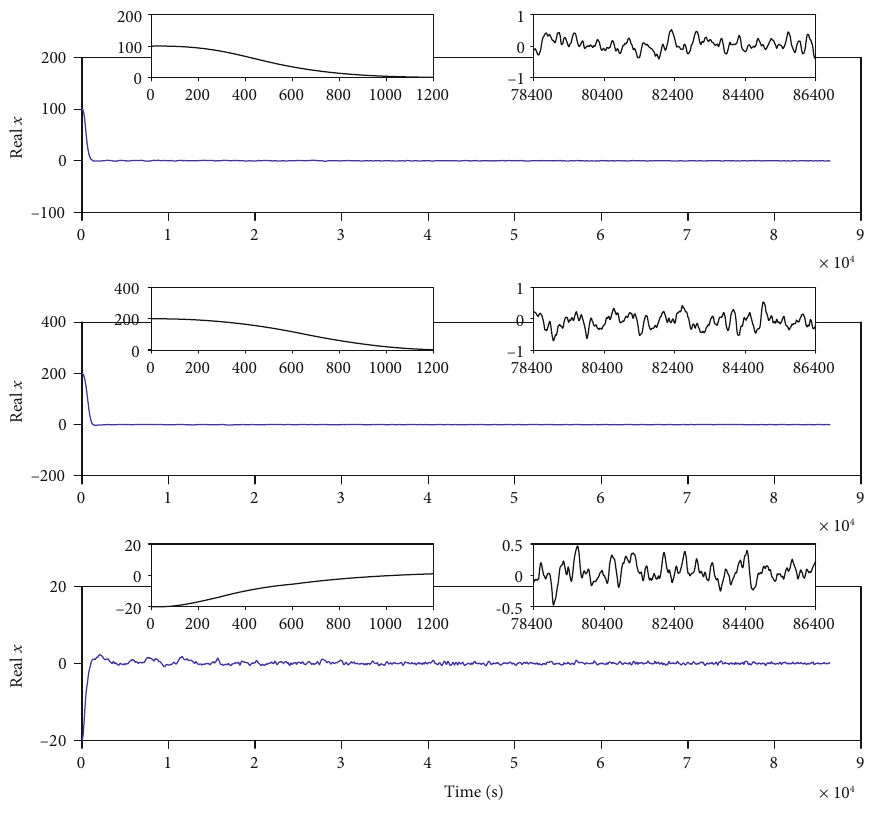
Figure 12: The real state change